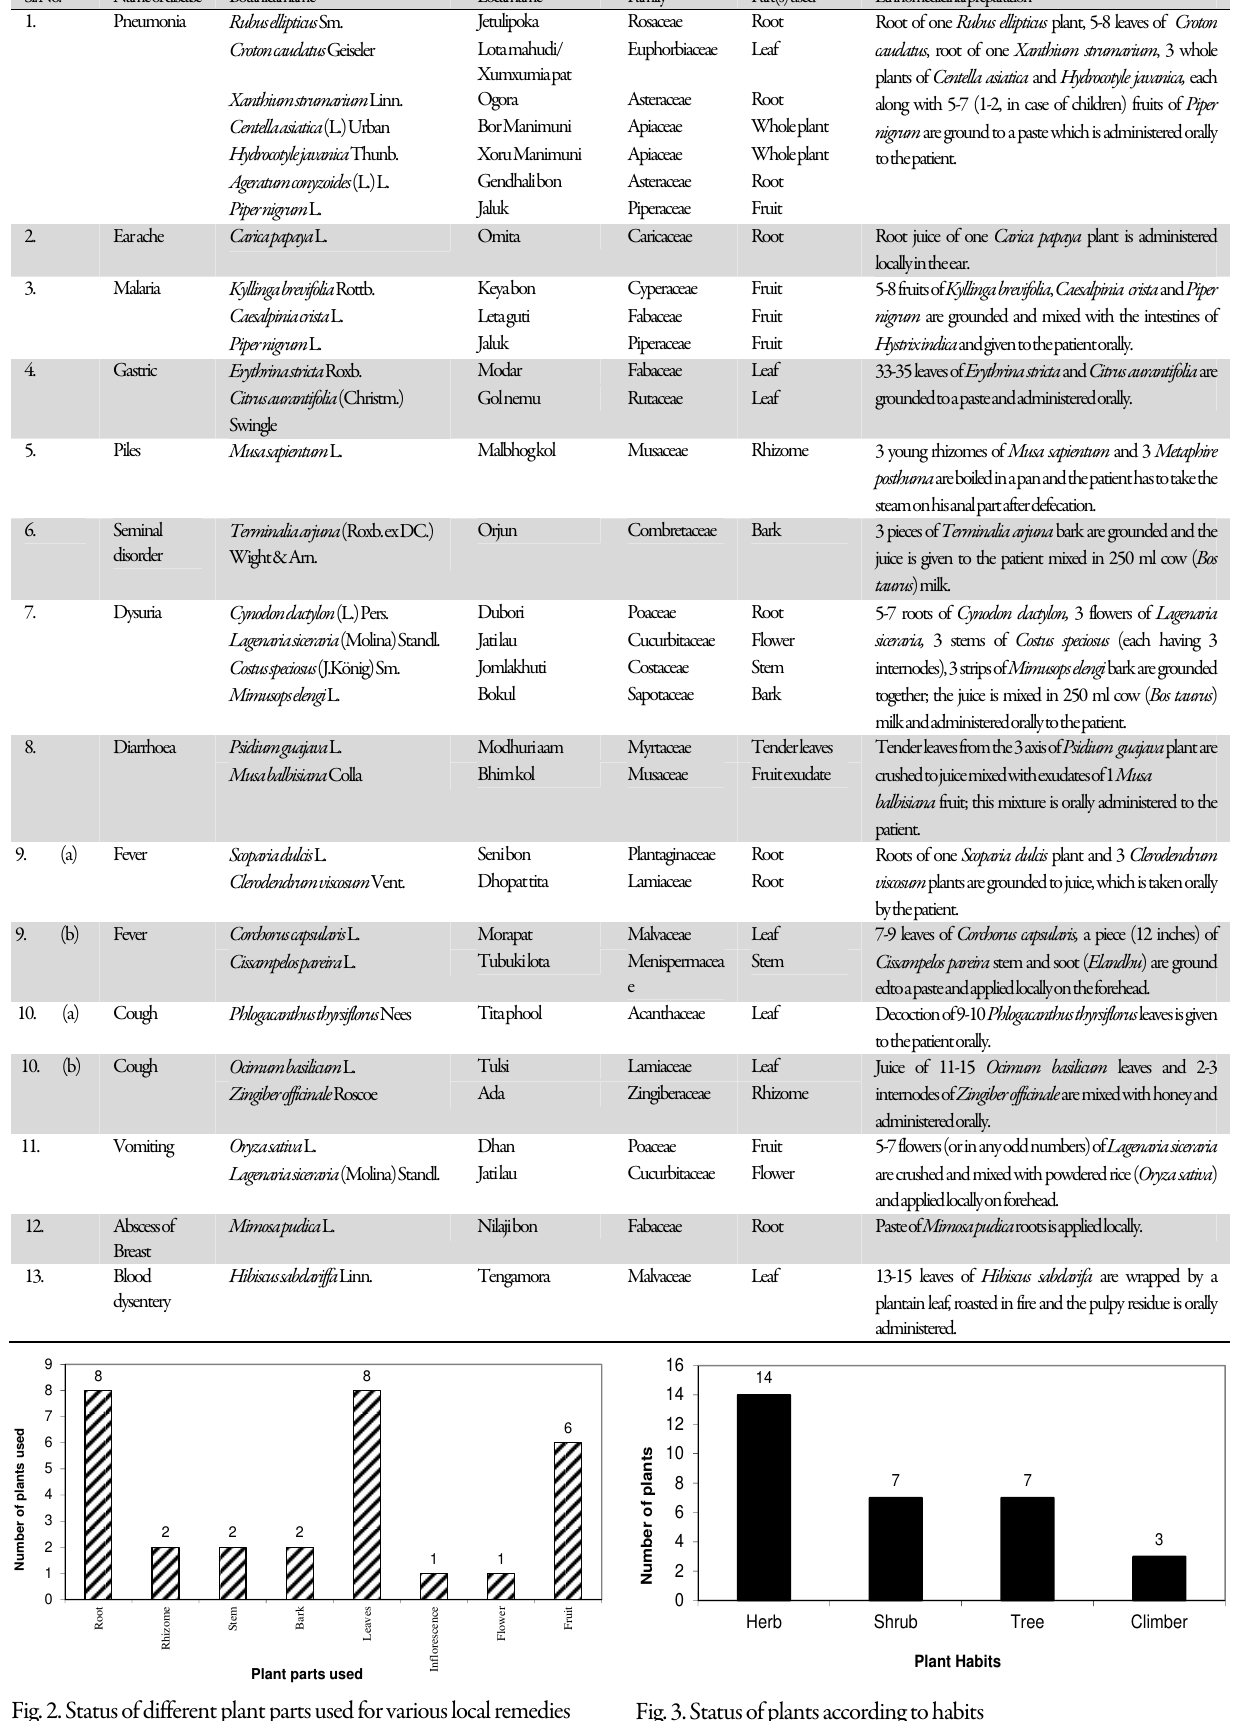
Table 1. Diseases with their respective ethnomedicinal formulations practiced by the Thengal-Kacharis population within the study site Sl. No.